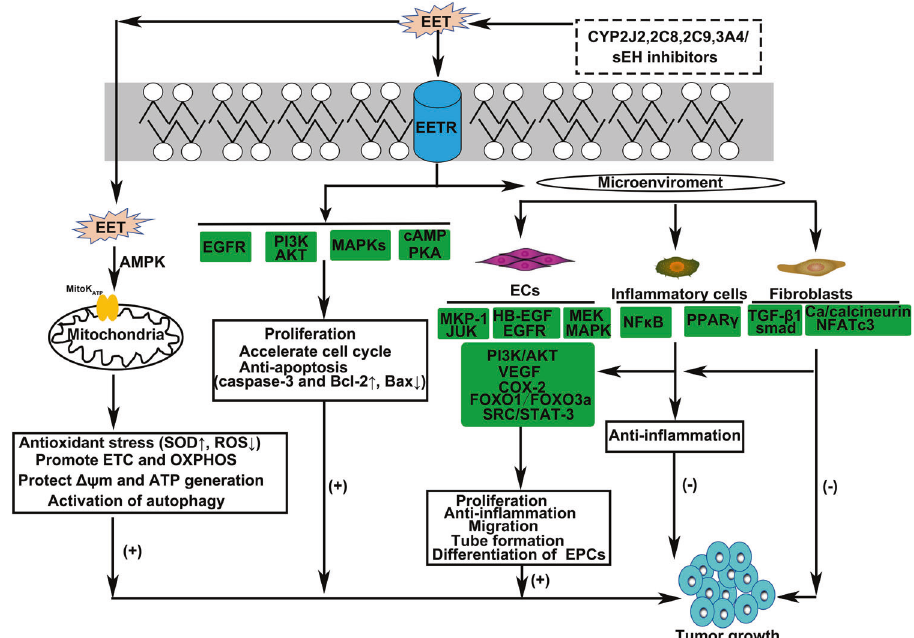
Fig. 3 The mechanisms of actions of EETs on tumor growth. EETs accelerated proliferation, cell cycle, and protected carcinoma cells from apoptosis through multiple signal transduction pathways. Besides, EETs improved mitochondrial function and prevented carcinoma cells from oxidative stress damage. In addition, EETs also were found to regulate multiple important cells in TME, such as promoting endothelial cell angiogenesis, fi broblast activation, and anti-in fl